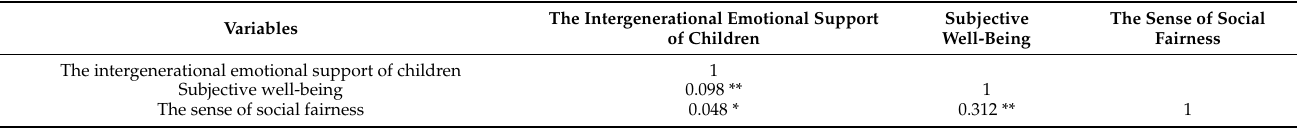
Table 2. Descriptive statistics and correlation among